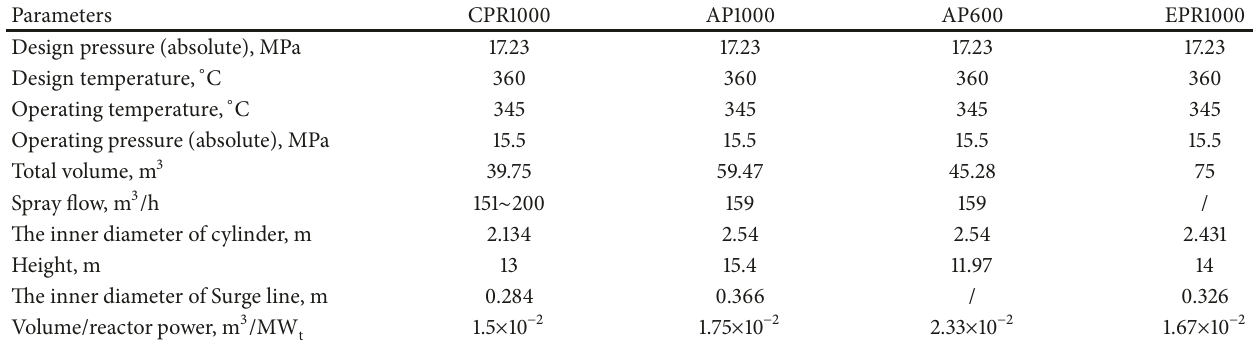
Table 1: Basic design parameters of different PWR pressurizers.